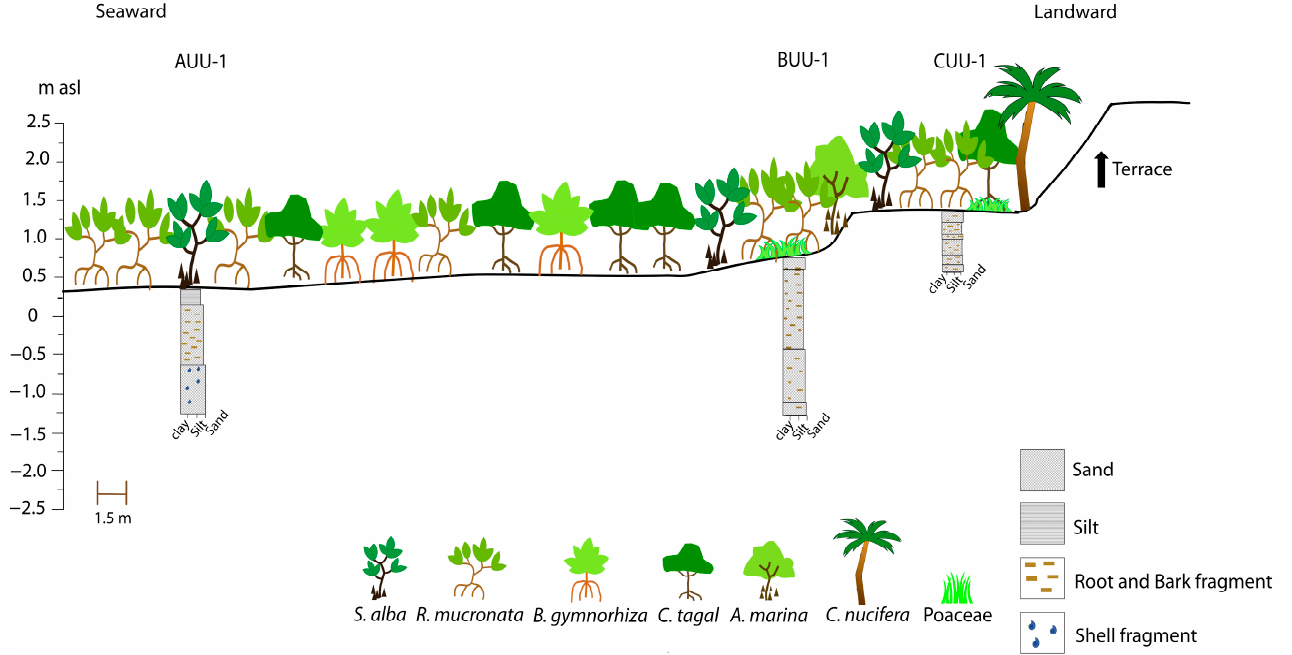
Figure 2. A cross-section showing the ecological distribution and dominant mangrove species from landward to seaward in the Unguja Ukuu mangrove area and coring sites including the stratigraphic details of AUU1, BUU1 and CUU1 cores.